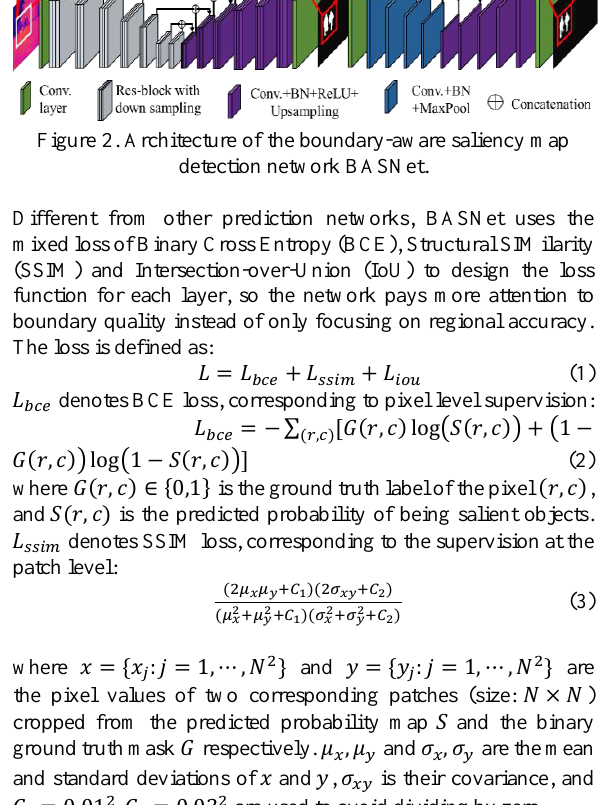
Figure 3. The fusion of the thermal image with the corresponding saliency